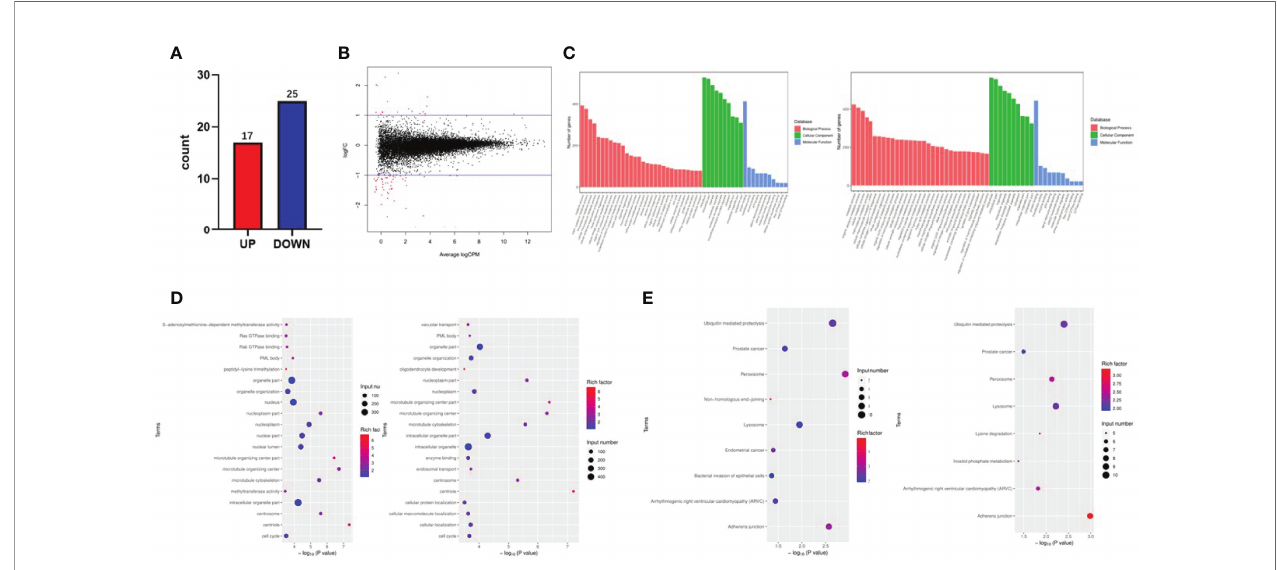
FIGURE 3 | Fat mass and obesity-associated protein (FTO) effects on the transcription pro fi le of papillary thyroid carcinoma (PTC) cells by RNA-seq. (A, B) A volcano plot shows the statistically upregulated (red) and downregulated (blue) genes between PTC-1-vector cells (control) and PTC-1-Lv-FTO cells (FTO overexpression), logFC <-1 or logFC >1, p 0.05, false discovery rate <0.05. (C) Signal pathways related to upregulated and downregulated genes reveal the role of differentially expressed genes in signal transduction. (D) The Kyoto Encyclopedia of Genes and Genomes analysis shows that FTO-over-expressed regulatory pathways are involved in cell proliferation, cell cycle, and apoptosis. (E) Gene ontologies related to the upregulated and downregulated genes between PTC-1- vector cells (control) and PTC-1-Lv-FTO cells (FTO overexpression).